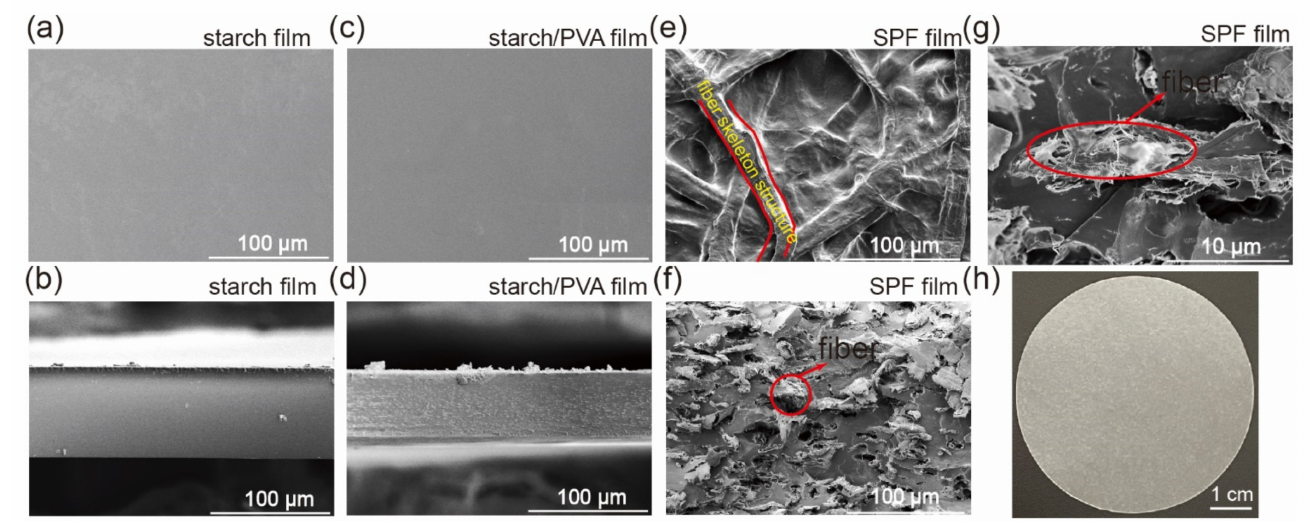
Figure 2. SEM images of SPF films. ( a ) Upper surface and ( b ) cross-section of starch film (S 100 P 0 F 0 ). ( c ) Upper surface and ( d ) cross-section of starch-PVA composite film (S 80 P 20 F 0 ). ( e ) Upper surface and ( f , g ) cross-section of starch-PVA-fiber composite film (S 60 P 15 F 25 ). ( h ) Photos of starch-PVA-fiber composite film (S 60 P 15 F 25 ).